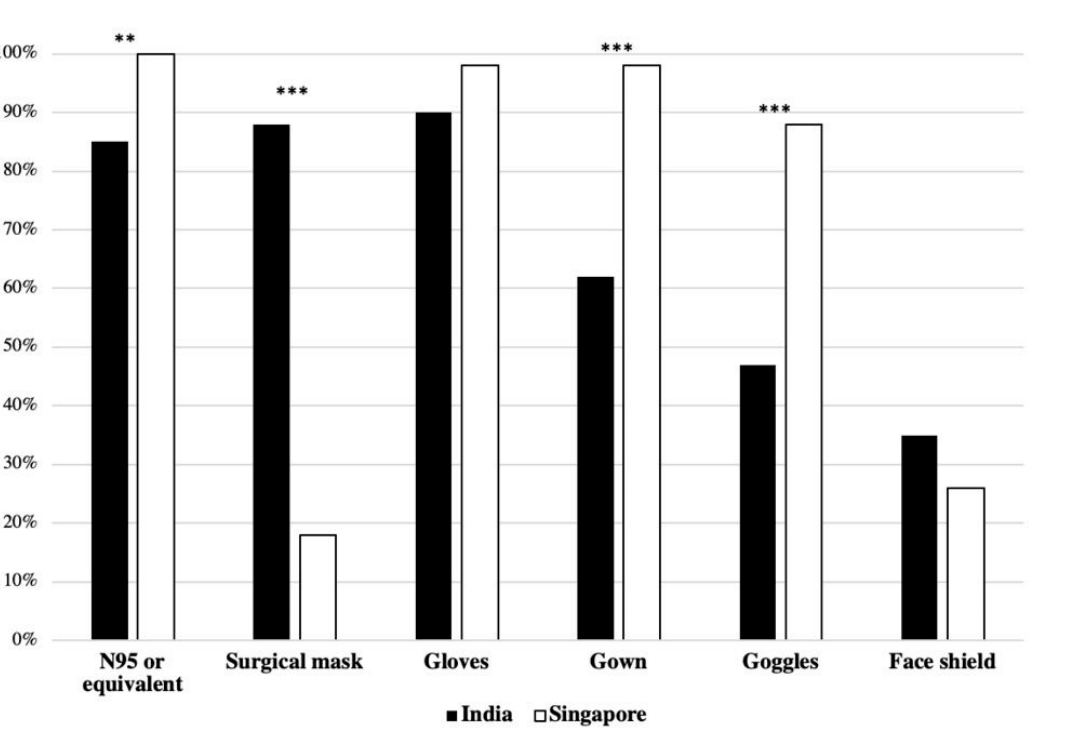
Table 2. Comparison of impact of PPE usage and related thermal stress, duration of usage, time taken for donning and doffing the PPE, whether or not PPE could be removed during breaks, availability